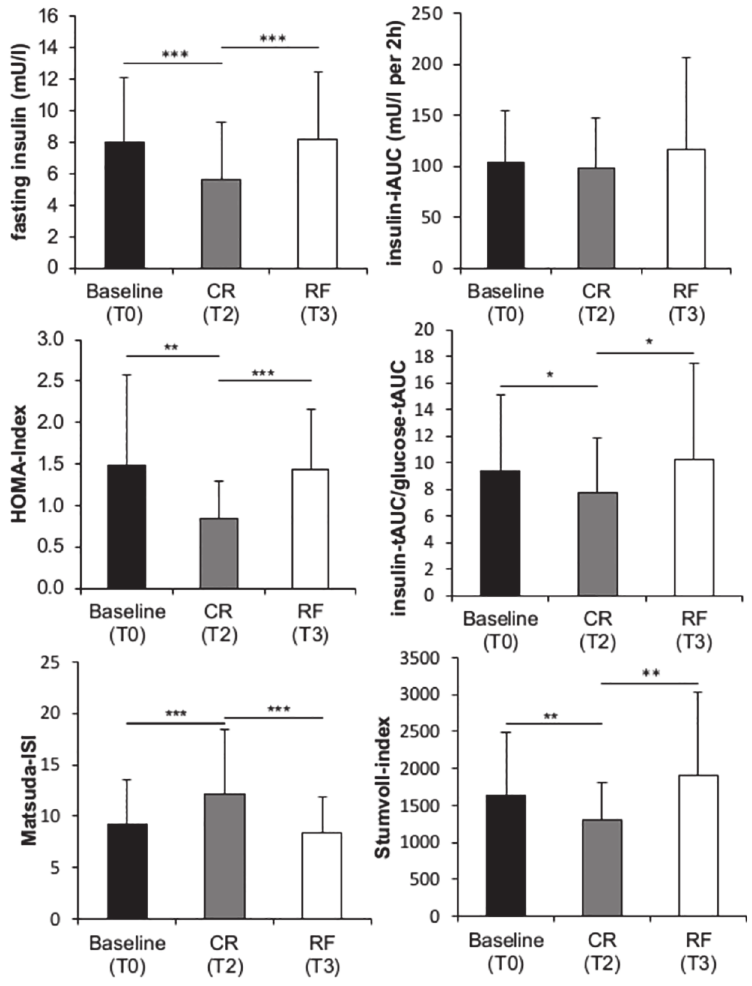
Fig 3. Comparison between fasting insulin level, IS (HOMA-index and Matsuda-ISI) as well as insulin secretion (insulin-iAUC, insulin-tAUC/glucose-tAUC, Stumvoll-index) at baseline (T0), after caloric restriction (CR, T2) and refeeding (RF, T3). * p < 0.05, ** p < 0.01, *** p < 0.001; Repeated